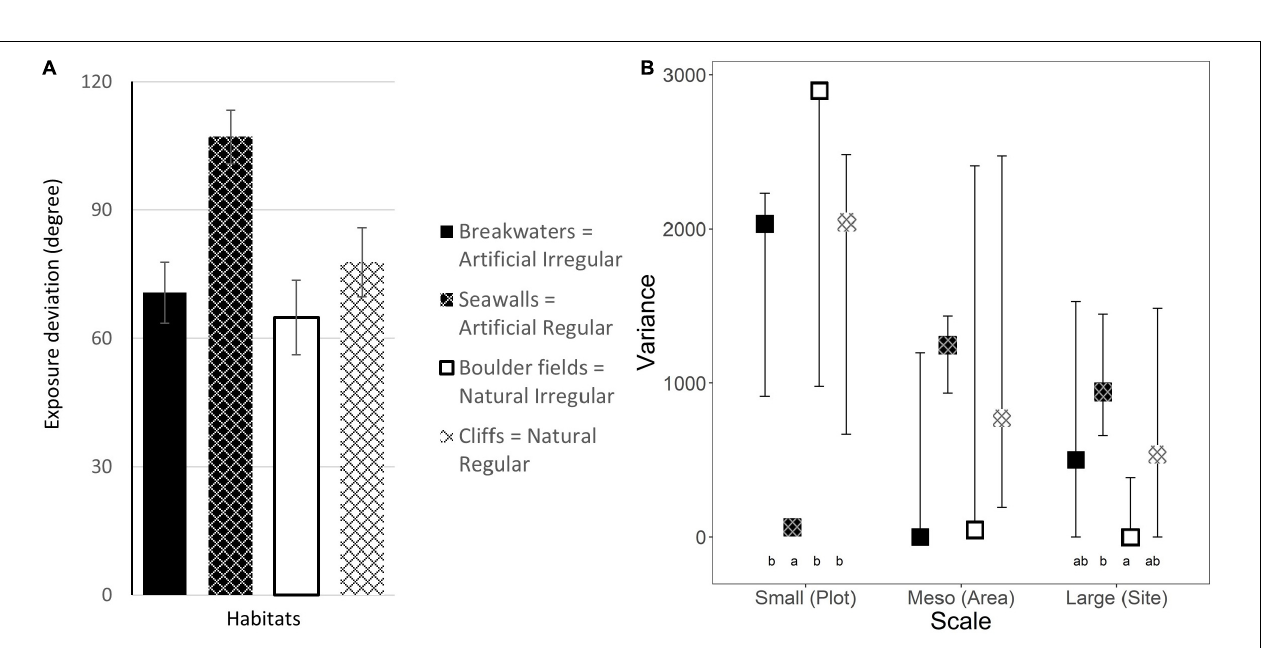
FIGURE 4 | (A) Mean exposure deviation ( ± 1 SE; data are averages of 2–4 plots at each of 4 areas at each of 3 sites, n = 39–48) and (B) estimated variance in Exposure ( ± 95% CI from bootstrapping) at each scale for the four combinations of habitat Types and Morphologies. Letters indicate significant differences from pairwise-tests ( Supplementary Table 2